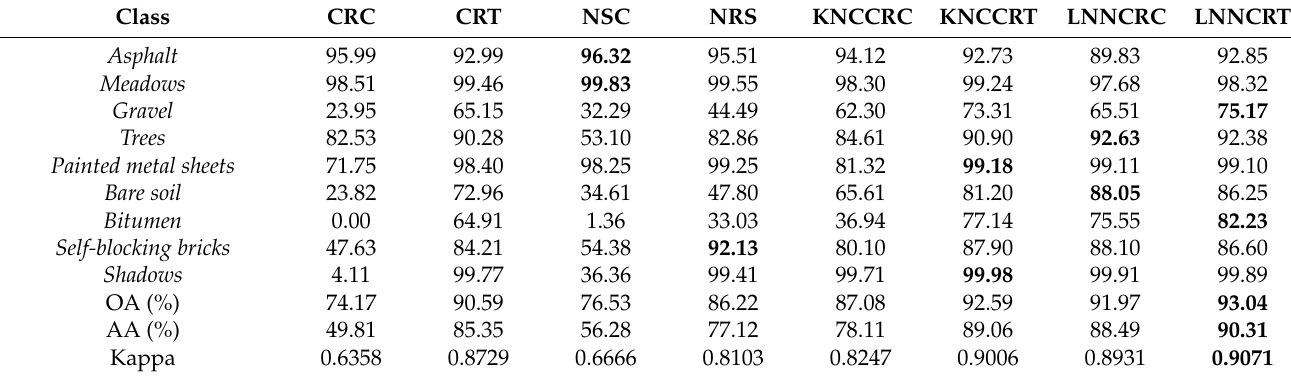
Table 3. Classification accuracy of different methods for land cover